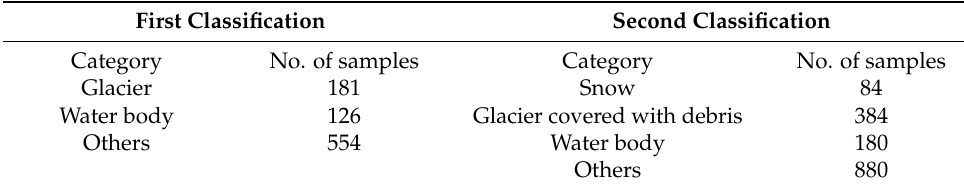
Table 3. Type and number of sample points.